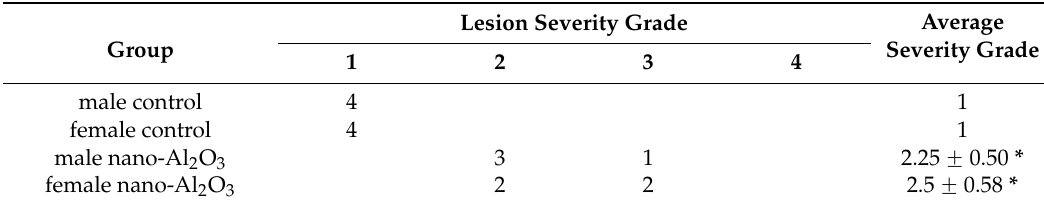
2 O 3 treatment.